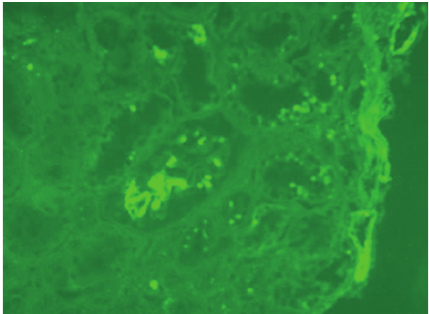
Figure 1: Immunofluorescence study in a patient with C1q nephropathy showing strong mesangial staining.